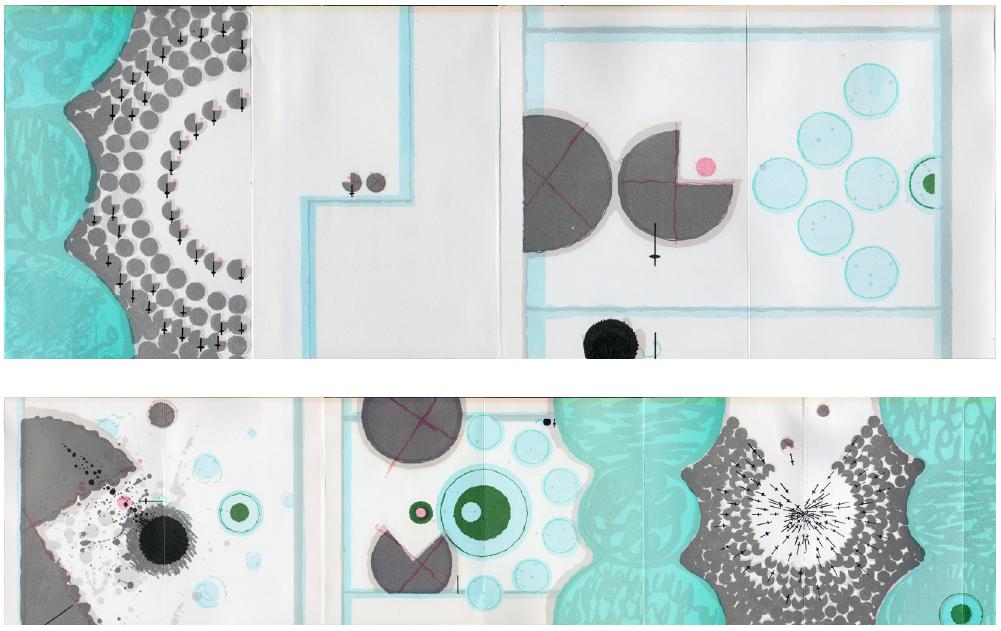
Fig. 15 Warja Lavater, The royals announce the imminent birth of the princess ; the royals receive the seven good fairies ; leaving the evil fairy out . Warja Lavater (1982). La Belle au Bois Dormant . Paris: Maeght éditeur Fig. 16 Warja Lavater, The bad fairy breaks in and casts the curse ; the fairy godmother protects the child ; the queen orders to destroy the spindles ; Belle receives the homage of the castellans . Warja Lavater (1982). La Belle au Bois Dormant . Paris: Maeght éditeur (below).